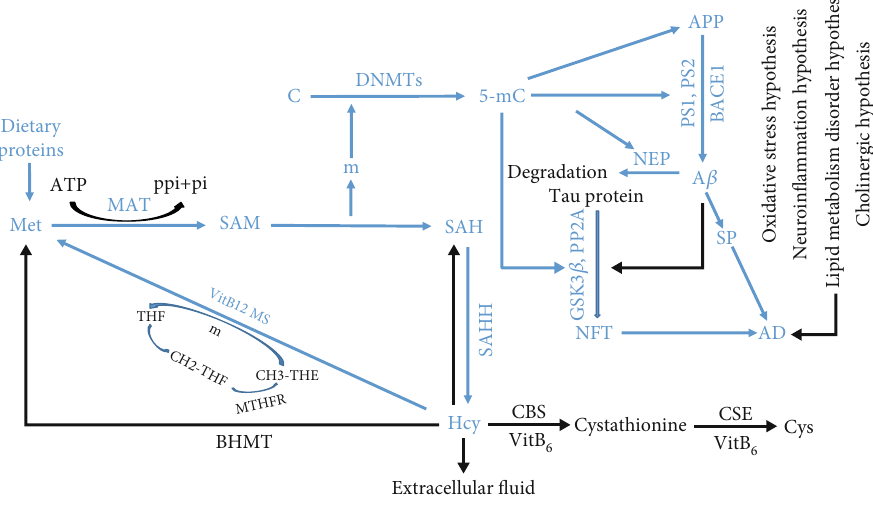
Figure 1: The mechanism of AD, DNA methylation and Hcy interaction. 5-mC: 5-methylcytosine; AD: Alzheimer ’ s disease; A β : amyloid- β ; APP: β -amyloid precursor protein; ATP: adenosine triphosphate; BACE1: β -secretase-1; BHMT: betaine-homocysteine methyltransferase; C: cytosine; CBS: cystathionine β synthase; CSE: cystathionine γ -lyase; Cys: cysteine; DMG: dimethylglycine; GSK3 β : glycogen synthase kinase 3 β ; Hcy: homocysteine; m: methyl; MAT: methionine adenosyltransferase; Met: methionine; MTHFR: methylenetetrahydrofolate reductase; MS: methionine synthase; NFT: neuro fi brillary tangle; NEP: neprilysin; PP2A: protein phosphatase 2A; PS1: presenilin-1; PS2: presenilin-2; SAH: S-adenosine homocysteine; SAHH: S-adenosine homocysteine hydrolase; SAM: S-adenosine methionine; SP: senile plaques; THF: